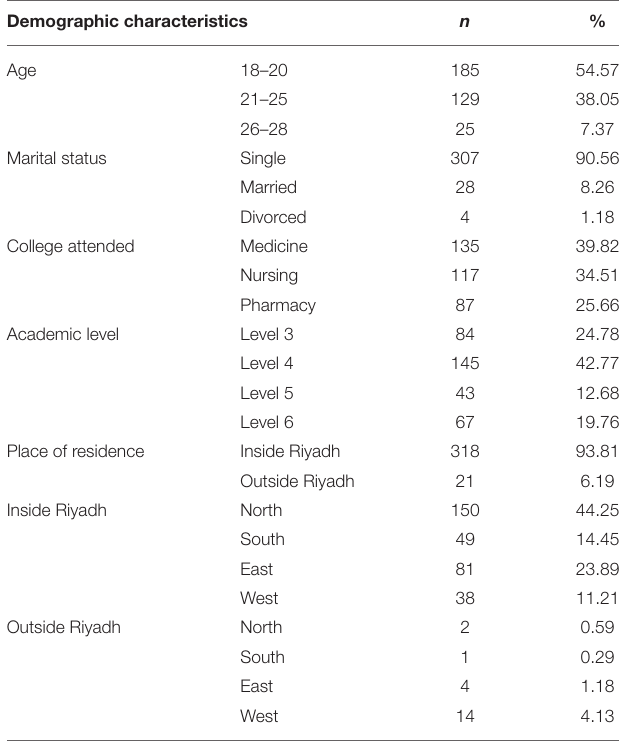
TABLE 2 | Demographic characteristics of female Saudi university students ( N =